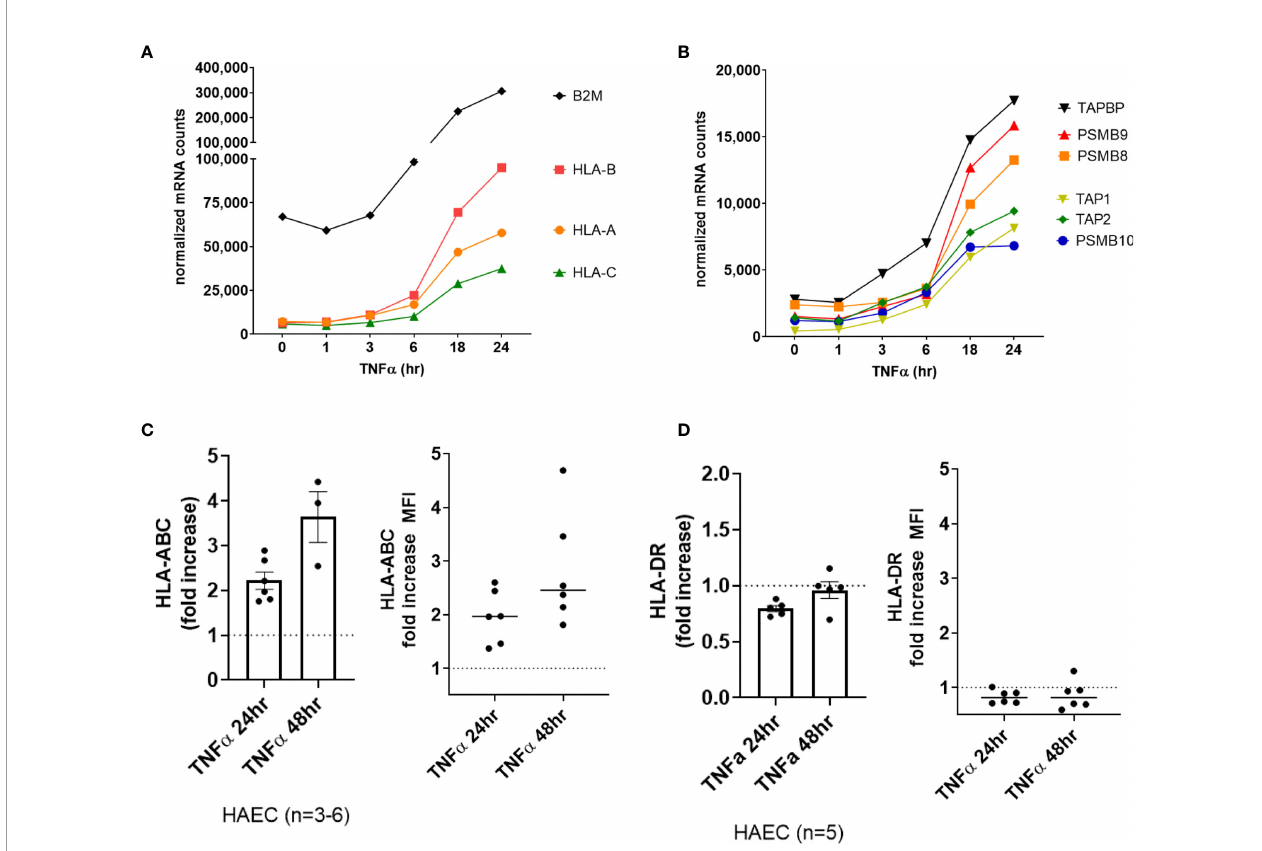
FIGURE 2 | TNF a induced endothelial expression of HLA class I, peptide presentation and immunoproteasome genes. (A) . HMEC-1 endothelial cells were stimulated with TNF a (20ng/mL) for 1hr, 3hr, 6hr, 18hr or 24hr. Time course of TNF a induced HLA class I transcripts in HMEC-1. One representative experiment is shown. Results are presented as absolute number of normalized mRNA counts for each gene, normalized to housekeeping controls. (B) Time course of TNF a induced antigen presentation transcripts in HMEC-1. One representative experiment is shown. Results are presented as absolute number of normalized mRNA counts for each gene, normalized to housekeeping controls. (C, D) Primary human endothelial cells (HAEC, HCAEC, HCMVEC, HPAEC, HPMVEC, HLSEC) were stimulated with TNF a for 24hr or 48hr. Cell surface HLA-ABC (C) and HLA-DR (D) protein was stained and detected by fl ow cytometry. Results are presented as the fold increase in MFI compared with untreated conditions (n=3-6 HAEC, left panel; n=6 EC from diverse vascular beds, right